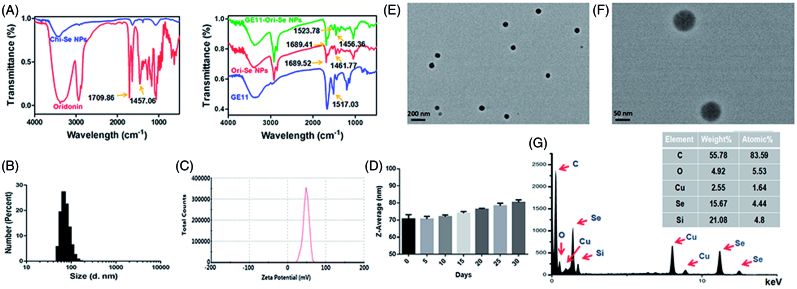
Characterization of GE11-Ori-Se NPs. (A) FTIR spectra of oridonin, Chi-SeNPs, Ori-Se NPs, GE11 peptide and GE11-Ori-Se NPs. (B) Size distribution of GE11-Ori-Se NPs and (C) Zeta potential distribution of GE11-Ori-Se NPs. (D) time-course of size distribution of GE11-Ori-Se NPs. (E,F) High-resolution TEM images of GE11-Ori-Se NPs, scale bars are 200 and 50 nm for (E) and (F), respectively. (G) TEM-EDS analysis of GE11-Ori-Se NPs.